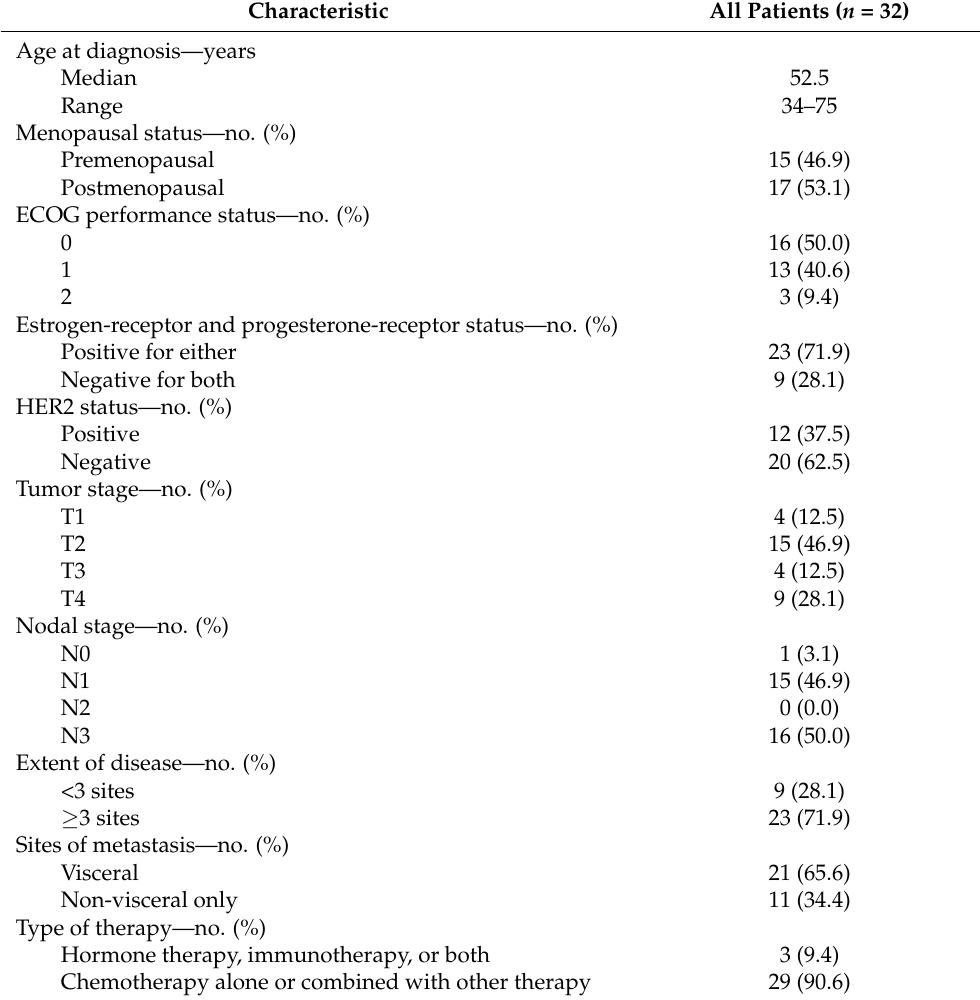
Table 1. Demographic and clinical characteristics of the patients. Characteristic All Patients ( n =